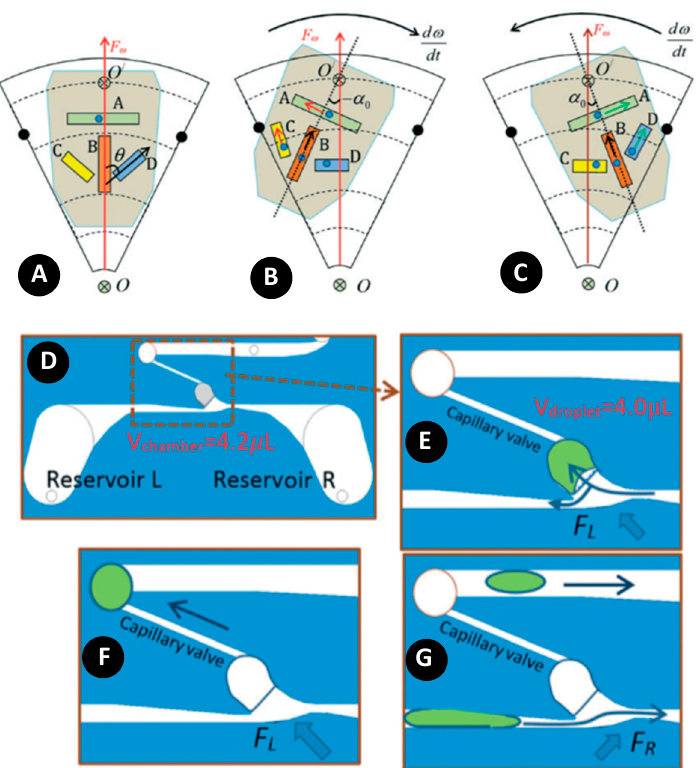
Figure 17. ( A – C ) The dynamics of flow in four different channels inside binary chip; channel A is azimuthal, channel B is diagonal, channels C and D are slanted; ( A ) Initial state; ( B ) LEFT state; ( C ) RIGTH state. ( D , E ) Producing droplet with binary chip. ( D ) Design of a binary chip with two reservoirs at the left and right, a metering chamber, a capillary valve, and a main channel; ( E ) In the LEFT state, the metering chamber is filled with liquid and the extra amount is directed to the left reservoir; ( F ) Increasing the rotating speed, the droplet breaks the capillary valve and enters to the main channel; ( G ) the extra amount of the liquid in the left reservoir returns back to the right reservoir. Reprinted with permission from [28].